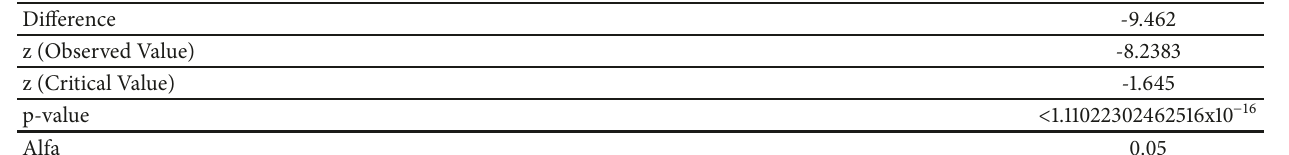
Table 11: Results of the Z-test for Module 2.